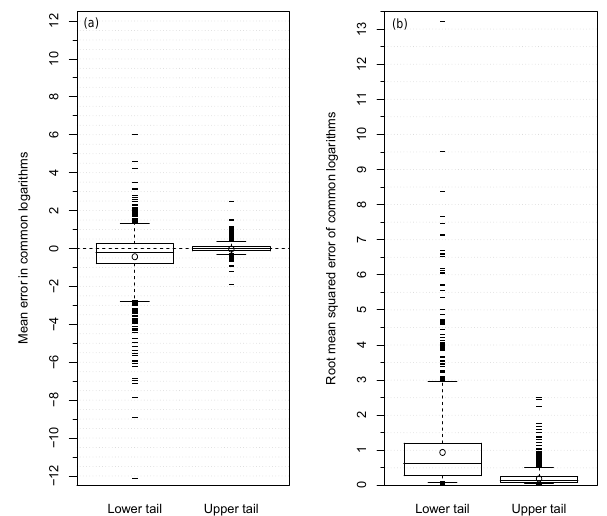
Figure 9. Distribution of logarithmic bias (a) , measured as the mean difference between the common logarithms of quantiles of observed and simulated streamflow (simulated minus observed) at 1168 streamgages across the conterminous USA, and logarithmic accuracy (b) , measured as the root mean squared error between the common logarithms of quantiles of observed and simulated stream- flow at the same streamgage, in the upper and lower quantiles of re- gionally regressed flow duration curves. The upper tail considers the eight quantiles in the highest 5% of streamflow, while the lower tail considers the eight quantiles in the lowest 5% of streamflow. The tails of the box plots extend to the 5th and 95th percentiles of the distribution; the ends of the boxes represent the 25th and 75th per- centiles of the distribution; the heavier line in the box represents the median of the distribution; the open circle represents the mean of the distribution; outliers beyond the 5th and 95th percentile are shown as horizontal